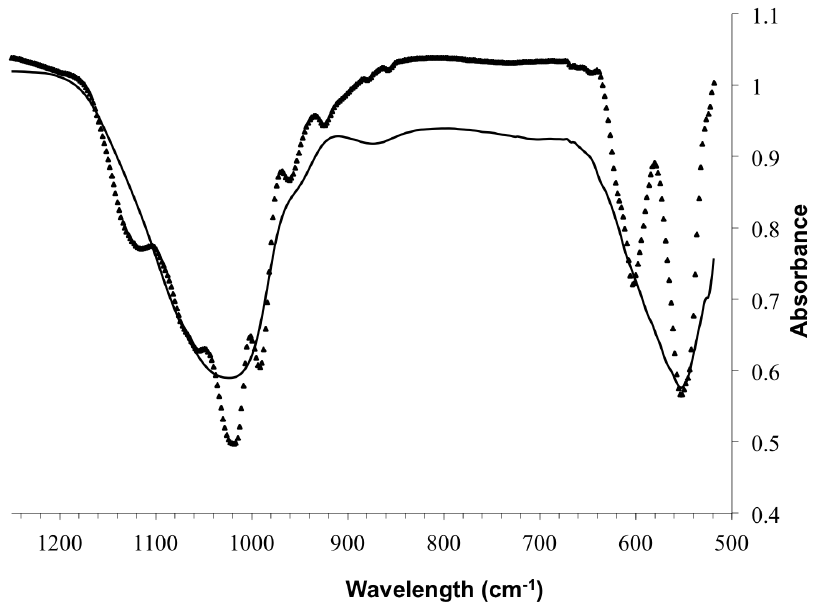
Figure 5. FTIR analysis of precipitate after 30 days of aging. Dried precipitate from sterile DSMZ medium (continuous line) and calcinated precipitate from the C. hydrogenoformans culture in the DSMZ medium (triangles).